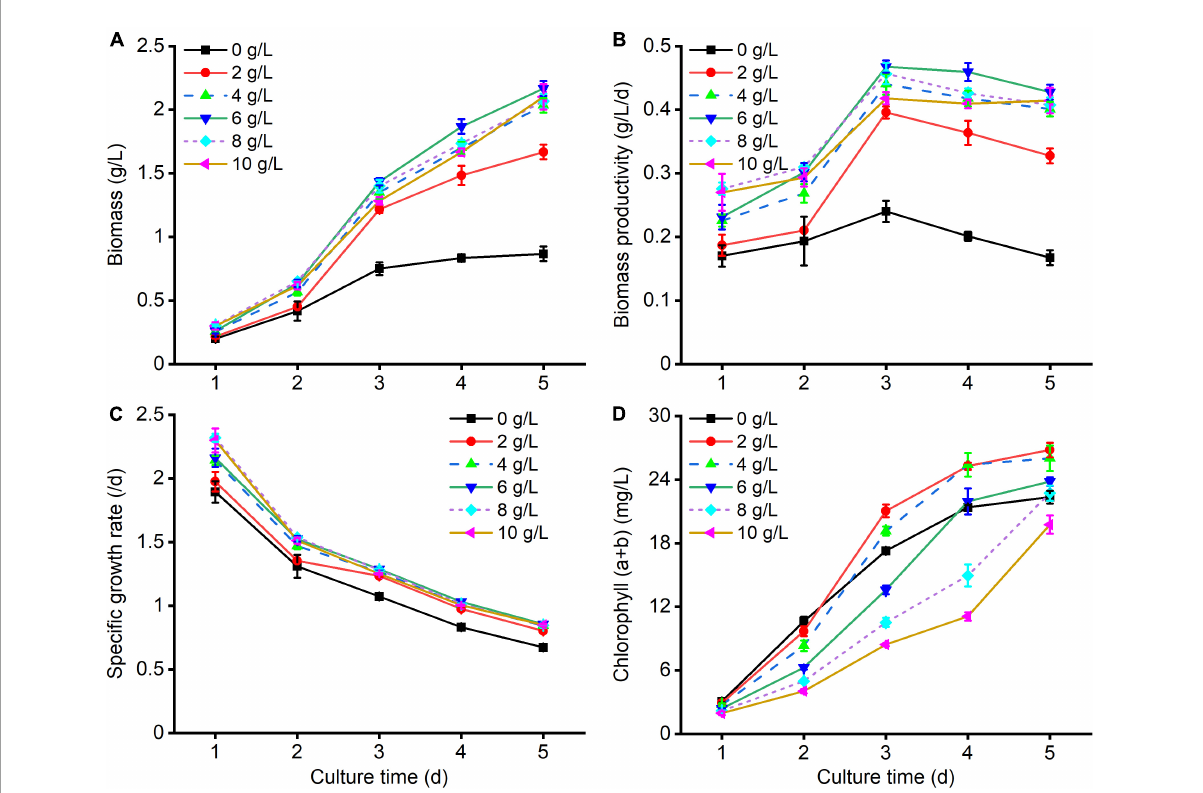
FIGURE1 Growth kinetics of C. reinhardtii under different carbon levels. (A–D) Are the changes of biomass, biomass productivity, specific growth rate, and chlorophyll ( a + b ) of C. reinhardtii under various NaAc concentrations (0, 2, 4, 6, 8, 10 g/L), respectively. The treatment of 0 g/L NaAc was considered as the control. Error bars indicate standard deviation ( n = 3). The same as below.